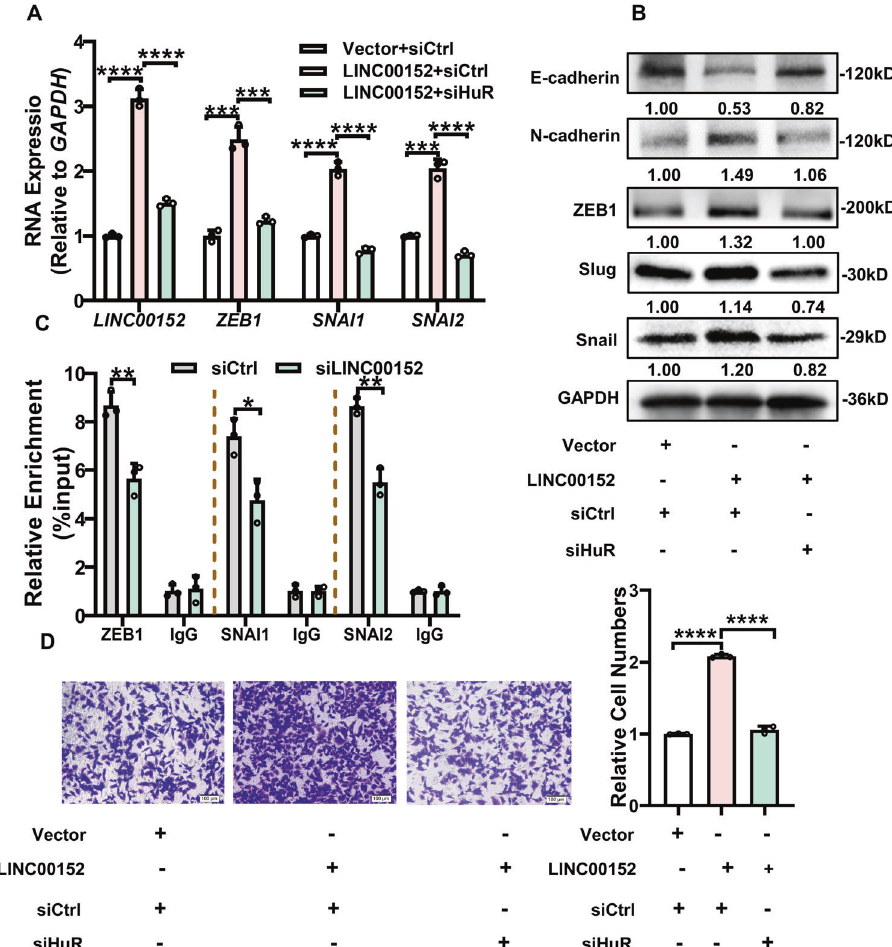
Fig. 7 LINC00152 promotes EMT and invasion depending HuR. A , B RT-qPCR and western blot was used to detect the expression of EMT associated genes (ZEB1, SNAI1, SNAI2, E-cadherin, N-cadherin) after overexpression LINC00152 and knockdown of HuR. C RIP assay of HuR binding RNAs of EMT related genes with an anti-Flag antibody in silenced LINC00152 or control cells. Data for each individual mRNA was normalized to the IgG pull-down product of that mRNA. D The invasive ability of overexpression LINC00152 and knockdown of HuR was analyzed by a transwell assay. Data have been presented as the mean ± SD of three independent experiments (** p < 0.01; *** p < 0.001; **** p < 0.0001. Student ’ s t